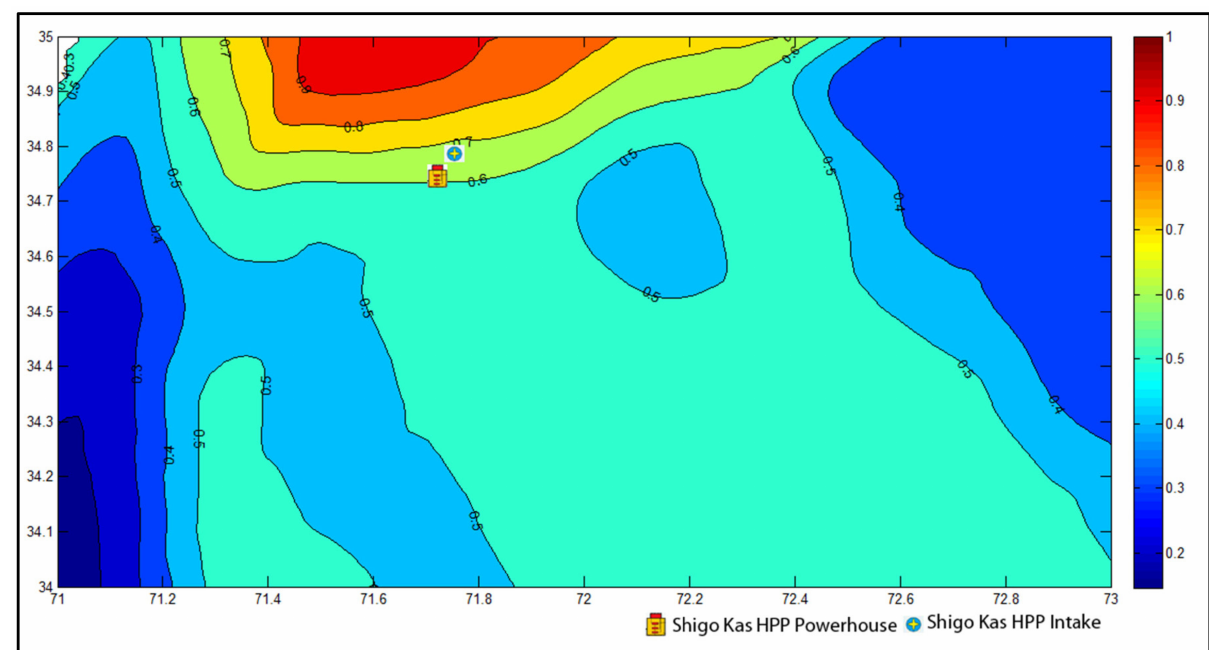
Figure 19. Seismic hazard map of the Shigo Kas HPP area for PGA at a 2500-year return period. The legend on the right side of map shows the PGA in terms of